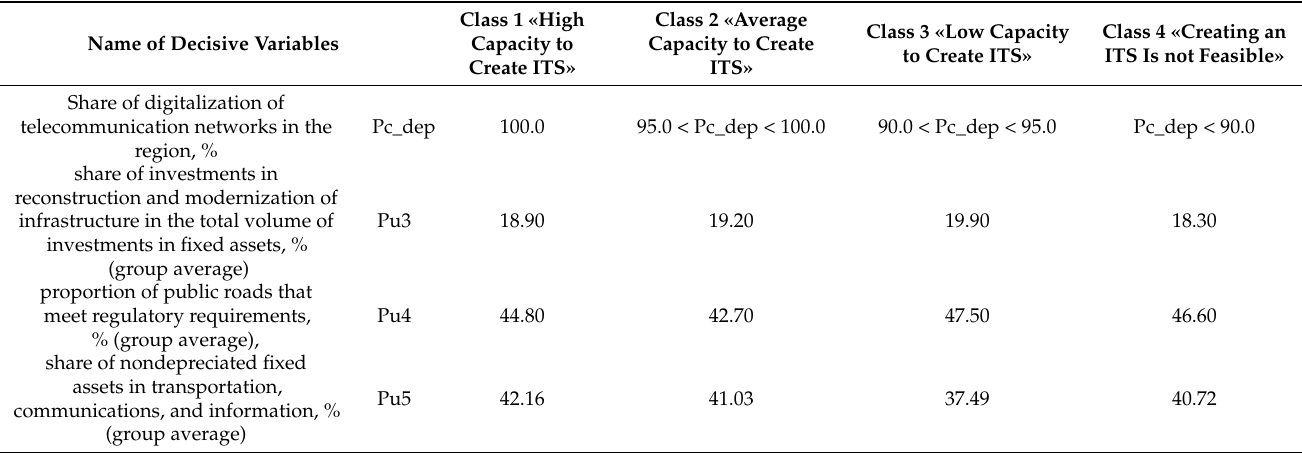
Table 3. Modeled classes of regions according to the level of capacity to create intelligent transporta- tion systems using the random forest method.